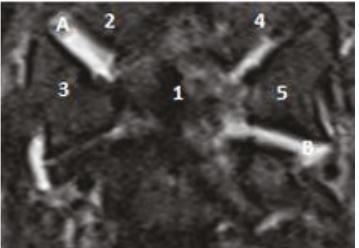
Figure 4: Cervical MRI axial view showing complete disruption of the left transverse ligament